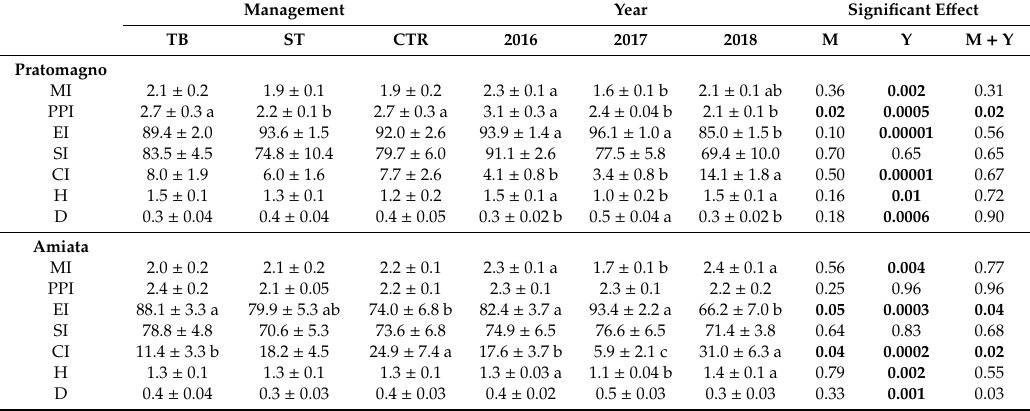
Figure 3. MDS analysis based on Bray–Curtis similarity index of microarthropod community abundance from soil samples in 2016, 2017, and 2018 in the Pratomagno and Amiata sites. Stress tests (S) are reported. Symbols represent di ff erent managements: TB (thinning from below) in dark green; ST (selective thinning) in hell green; CTR (control without thinning) in brown. Table 3. E ff ect of di ff erent managements on soil nematode indices. TB, thinning from below; ST, selective thinning; CTR, control without thinning; MI, maturity index; PPI, plant parasitic index; EI, enrichment index; SI, structure index; CI, channel index; H, Shannon-Weiner index; D, Simpson index. Standard errors ( ± ) are reported. Di ff erent letters indicate significant di ff erences at p < 0.05. Significant di ff erences are highlighted in